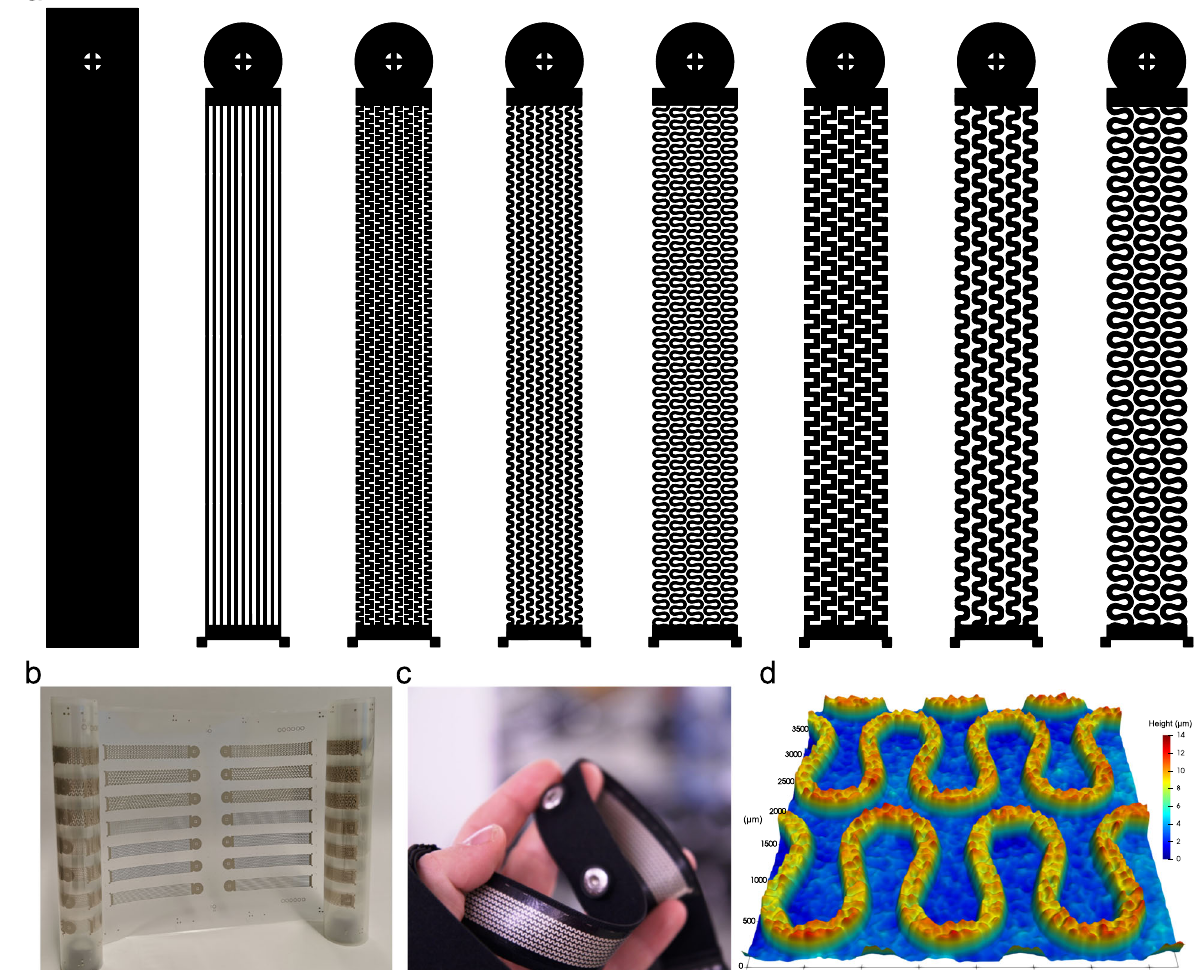
Fig. 1 Various shape electrodes R2R printed on the fl exible substrate (thermoplastic polyurethane). a Eight different shaped electrodes (115 × 20 mm). The designed endings allow easy incorporation with the cycling measurement system as well as the integration with the fabric belt for ECG measurements. Panel b depicts one of the printing trials where the electrodes were R2R printed on a fl exible TPU substrate with a supportive carrier. c An exemplary electrode implemented into the stretchable belt used for washing testing and ECG measurements. d Pro fi lometric analysis of R2R-printed